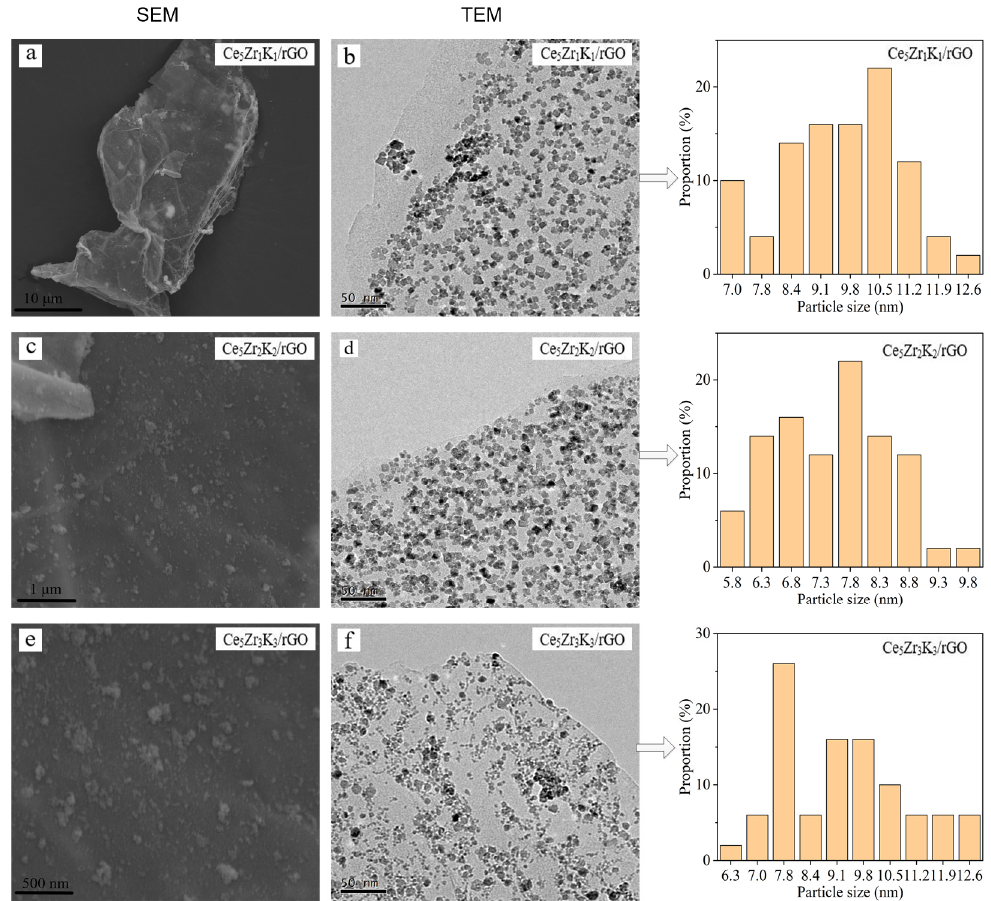
Figure 2. Scanning electron microscopy (SEM) and transmission electron microscopy (TEM) images of CeZrK/rGO catalysts.